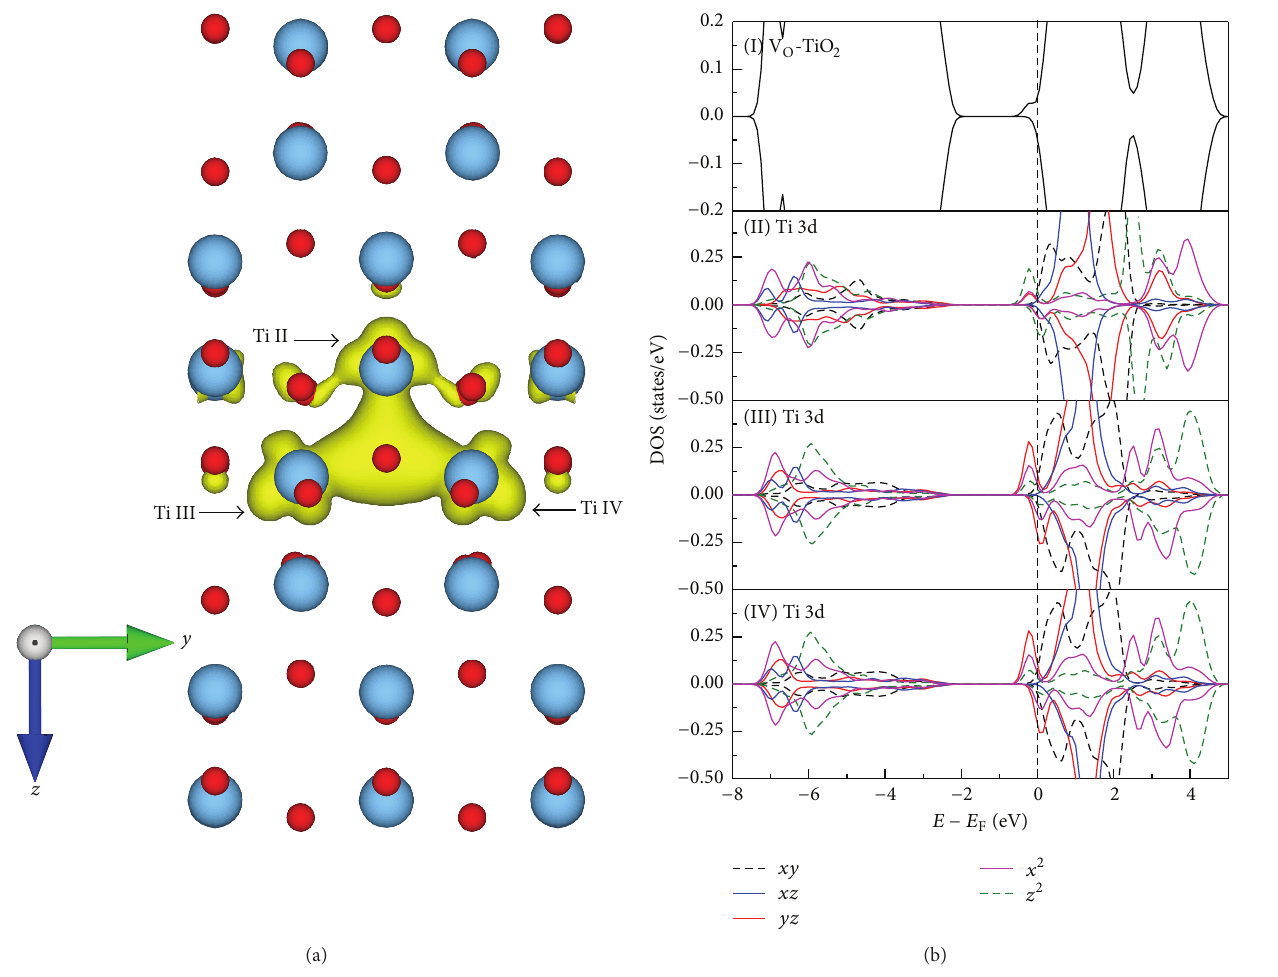
Figure 1: (a) Charge distribution of V O -doped anatase TiO 2 . (b) TDOS of V O -TiO 2 and the orbitally decomposed density of states for three Ti 3d electrons nearest to V O . The olive and black dashed curves represent the 𝑒 𝑔 bands; the red, blue, and magenta solid curves represent the 𝑡 2𝑔 bands, respectively.